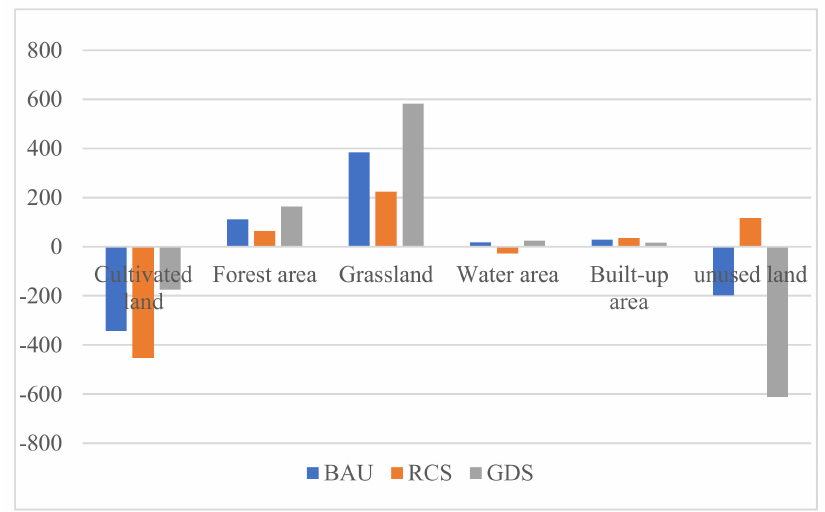
Figure 8. Growth of different land use types in different scenarios in Zhangye